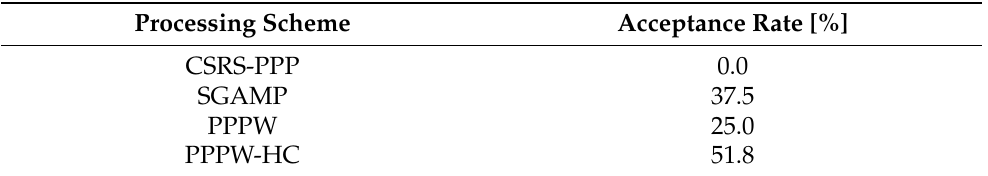
Table 6. The acceptance rates for GNSS-ZTD results of CSRS-PPP, SGAMP, PPPW, and PPPW-HC for